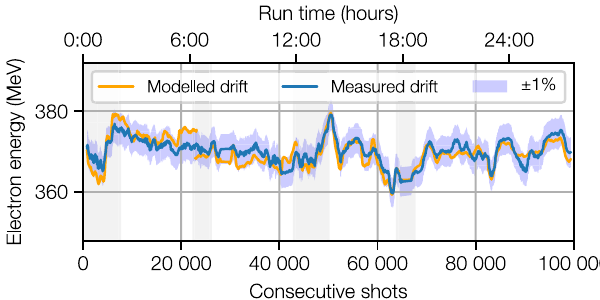
FIG. 5. Gray shaded areas mark the events used to derive the correlations ∂ E E , ∂ Z E , and ∂ θ E . By regularly updating the correlations, the parametrization of the electron energy drift can be extended to the full data